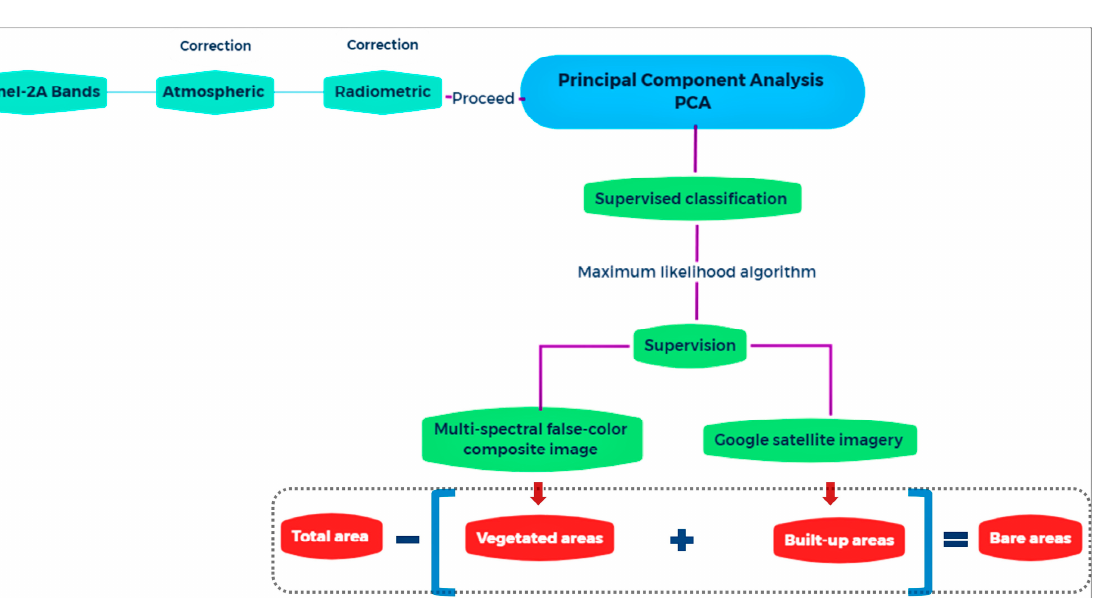
Table 2. Satellite products used for the